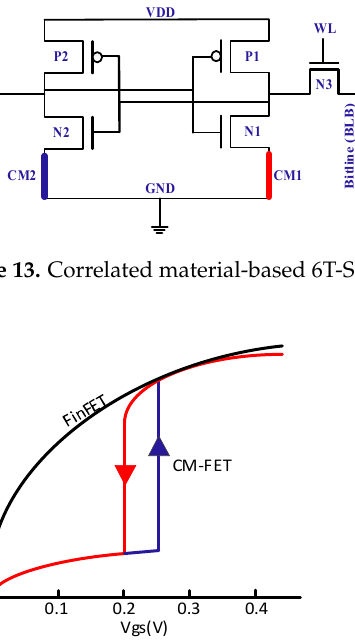
Figure 12. Graphene nano-ribbon structure of FinFET [50].